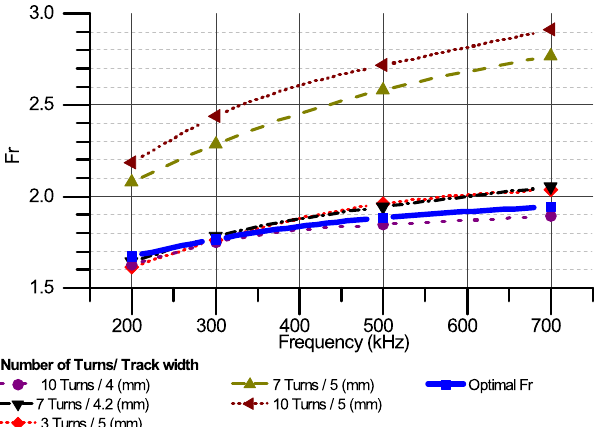
Figure 22. Group-3 measured R AC / R DC .